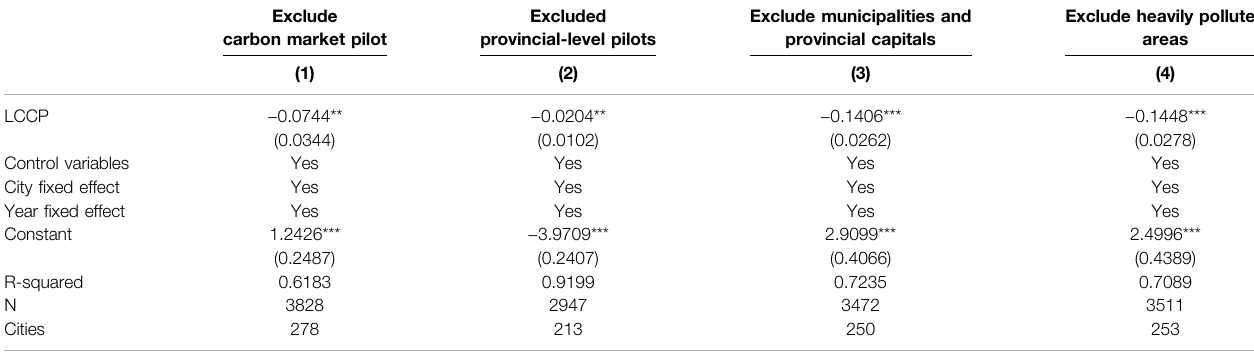
TABLE 8 | Robustness analysis: excluding interference policies and extreme samples.